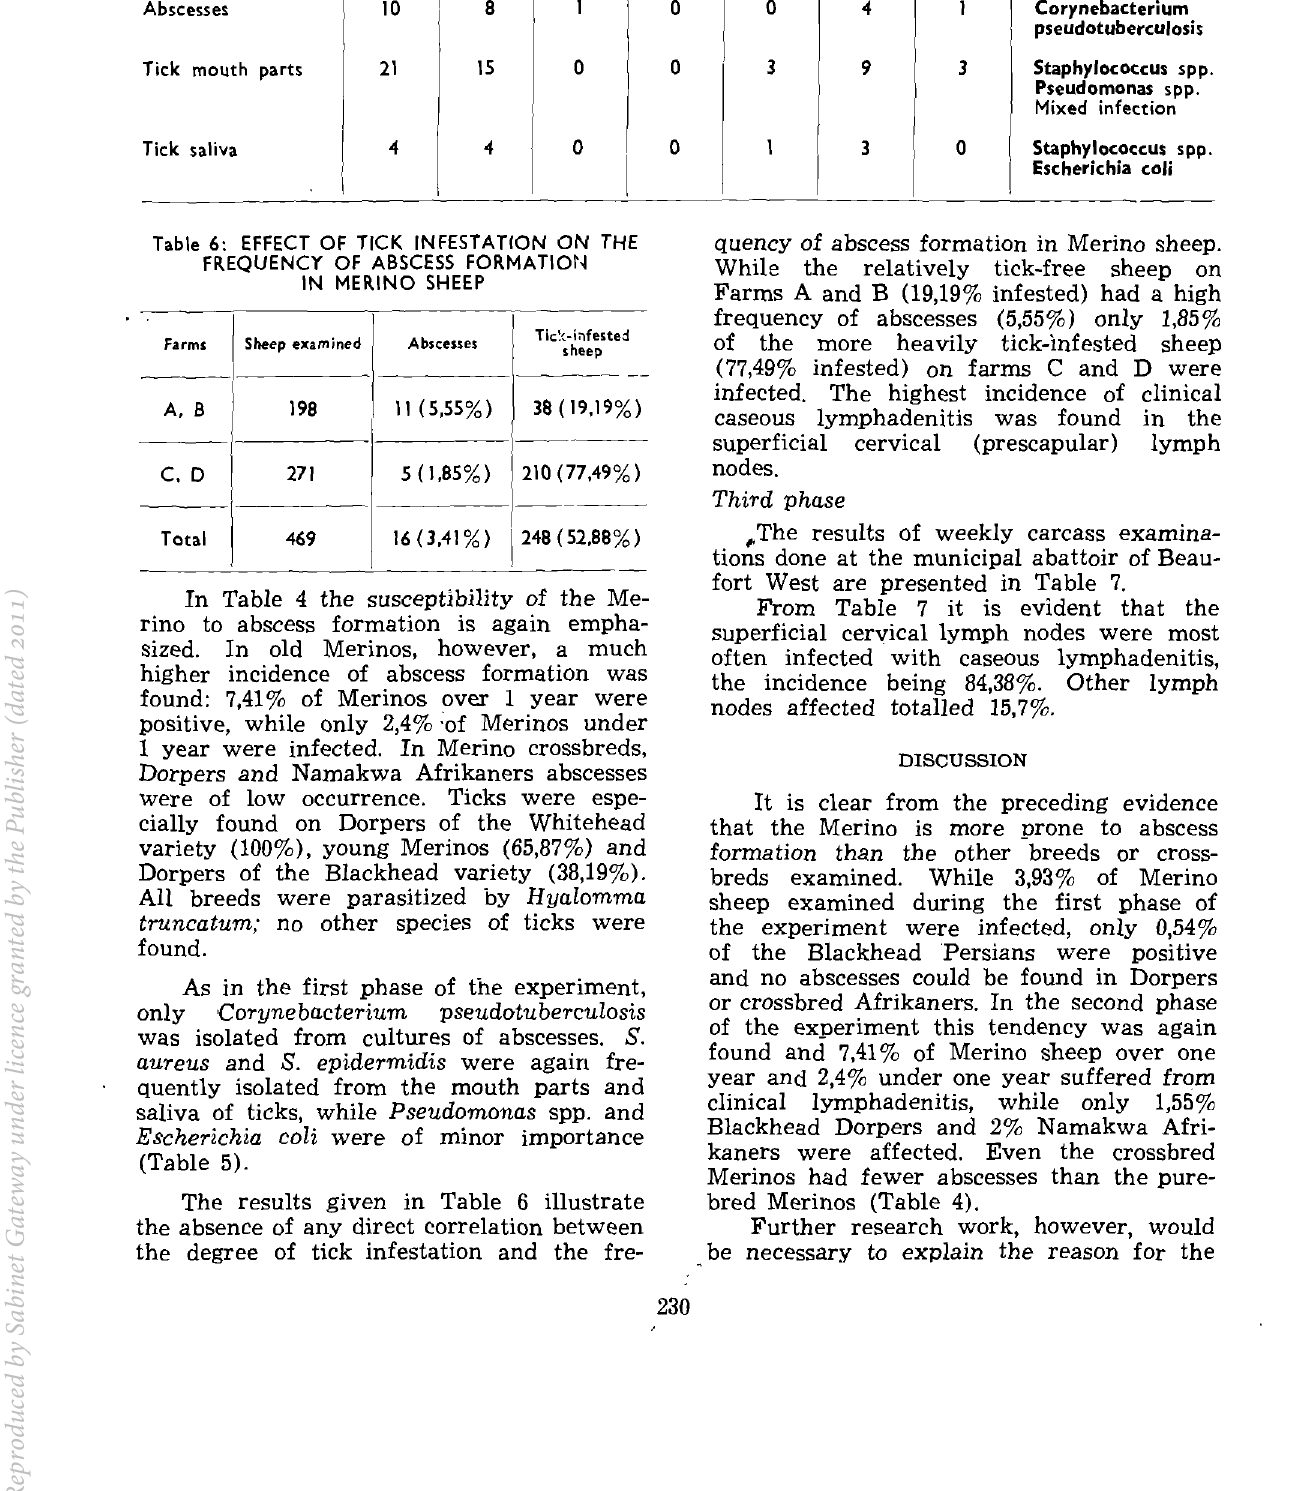
Table 5: MICRO-ORGANISMS ISOLATED FROM ABSCESSES AND TICKS